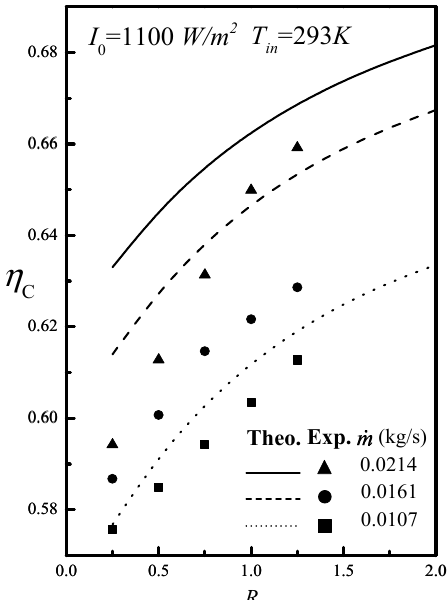
Figure 5. Effect of the recycle ratio on collector efficiency of the recycling cross-corrugated solar air collector ( I 0 = 1100 W/m 2 ).